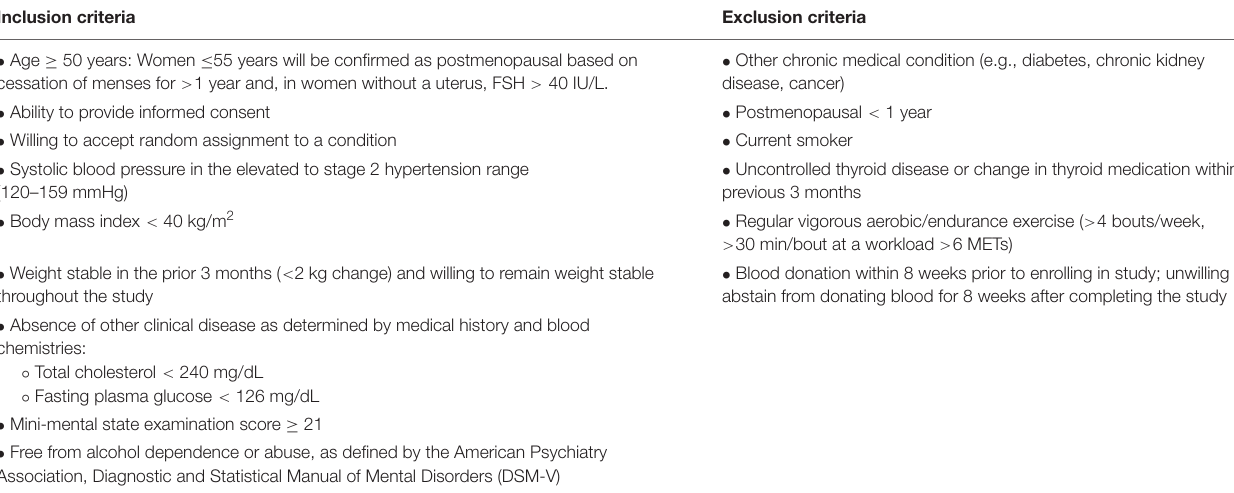
TABLE 1 | Inclusion and exclusion